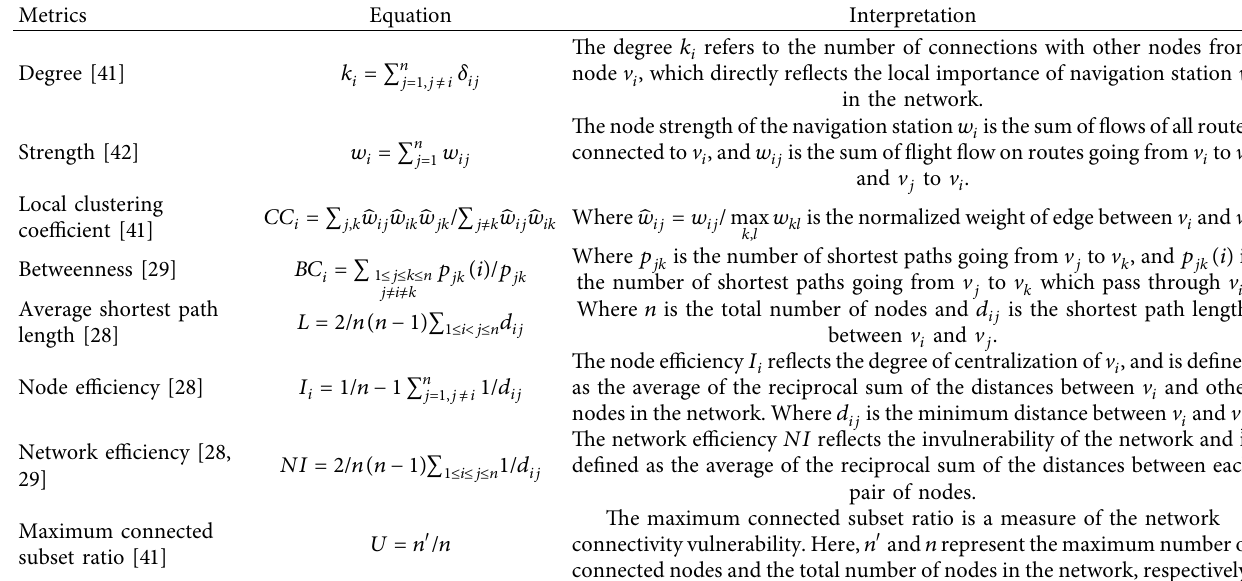
Table 1: The network metrics of navigation